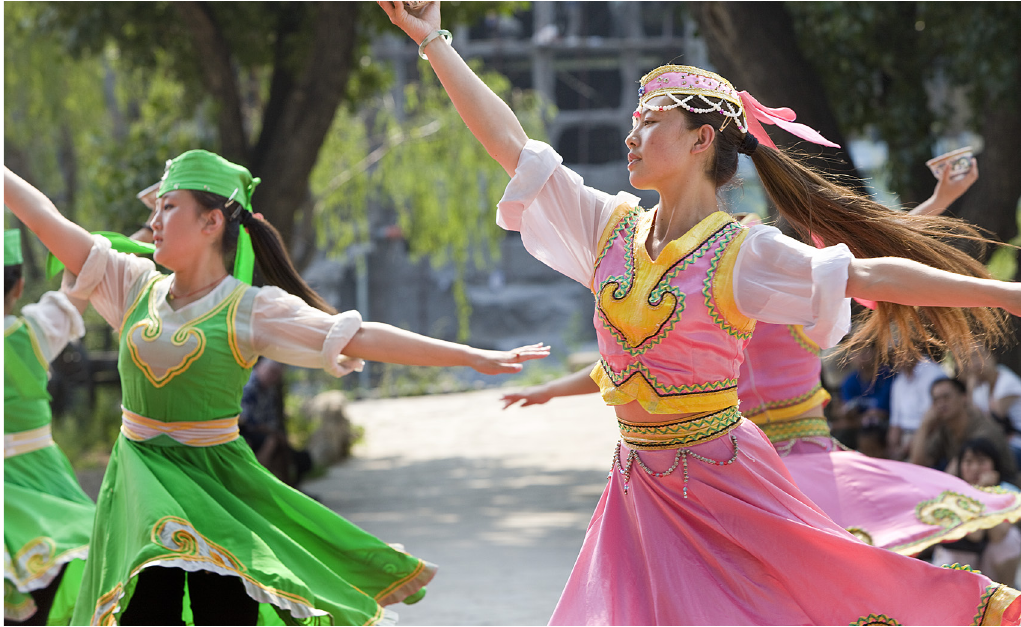
Figure 1: Performers at the Ethnic Culture Park enacting a “traditional Tibetan dance.” Photo: John